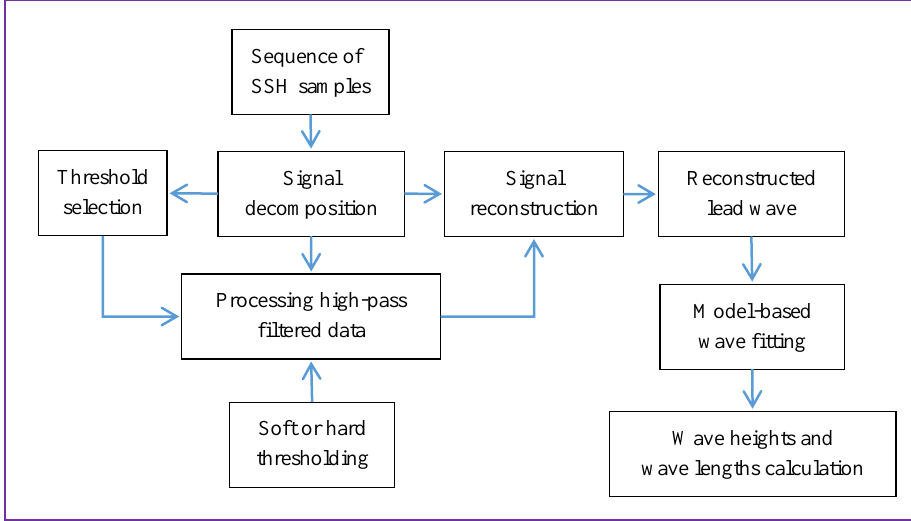
Figure 1. Block diagram of the wavelet based Tsunami lead wave reconstruction